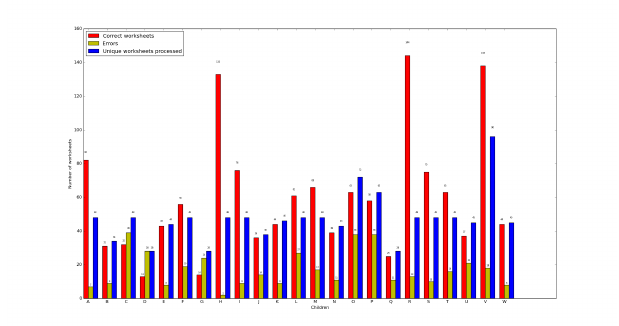
Figure 14. Variations in the number of correct answers, the number of errors and the number of unique worksheets processed by the different children on the worksheets of the serious games.